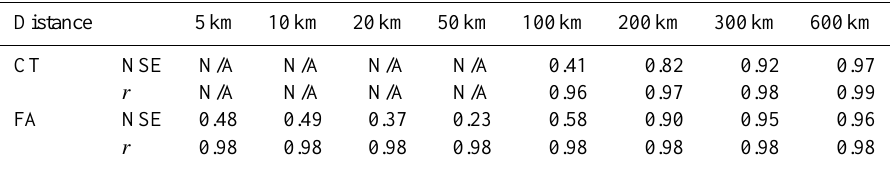
Table 1. Correlation coefficient and NSE (Nash–Sutcliffe efficiency) between the EC flux and the other two methods. CT denotes Carbon- Tracker and FA denotes the flux aggregation method. Distance 5km 10km 20km 50km 100km 200km 300km 600km CT NSE N/A N/A N/A N/A 0.41 0.82 0.92 0.97 r N/A N/A N/A N/A 0.96 FA NSE 0.48 r 0.98 0.98 0.98 0.98 0.98 0.98 0.98